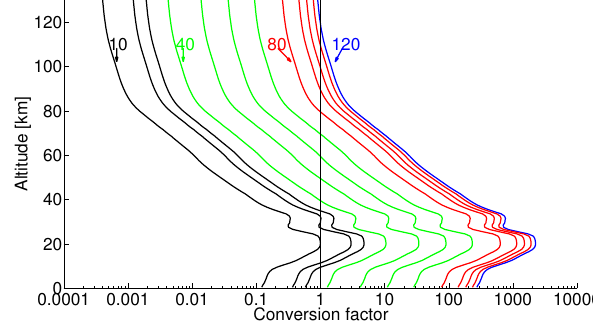
Fig. 6. Selected altitude-dependent factors for the conversion from fractional AVKs to vmr AVKs. Single curves, the labeling, and the coloring correspond to ones in Fig. 5, so that the curves belong to AVKs with target altitudes between 10 and 120km in 10km steps from left to right. It is obvious, that AVKs with high target altitudes are mainly amplified, whereas AVKs with low target altitudes are mainly